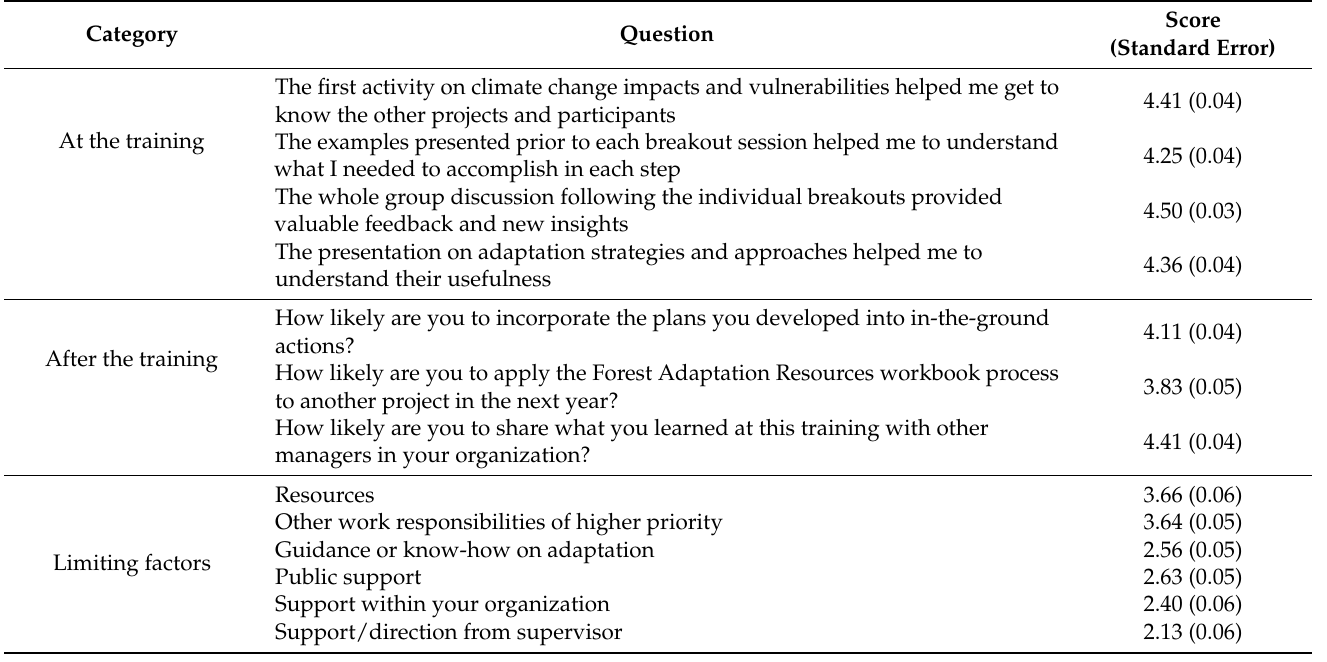
Table 2. Average evaluation scores (n = 467) addressing the effectiveness of different workshop components at the training, intent to apply elements of the training moving forward, and factors limiting adaptation planning (Score: 1 = Not at all; 5 =